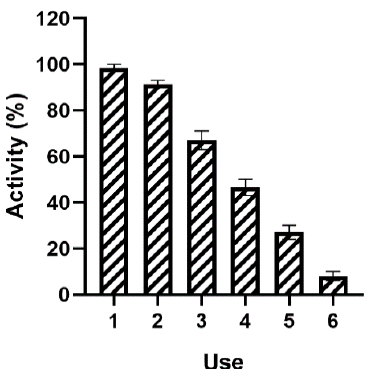
Figure 5. Operational stability of β‐ Glc co ‐ entrapped with dextran functionalized oxidized MNPs (Si@ β‐ Glc _DOxi).